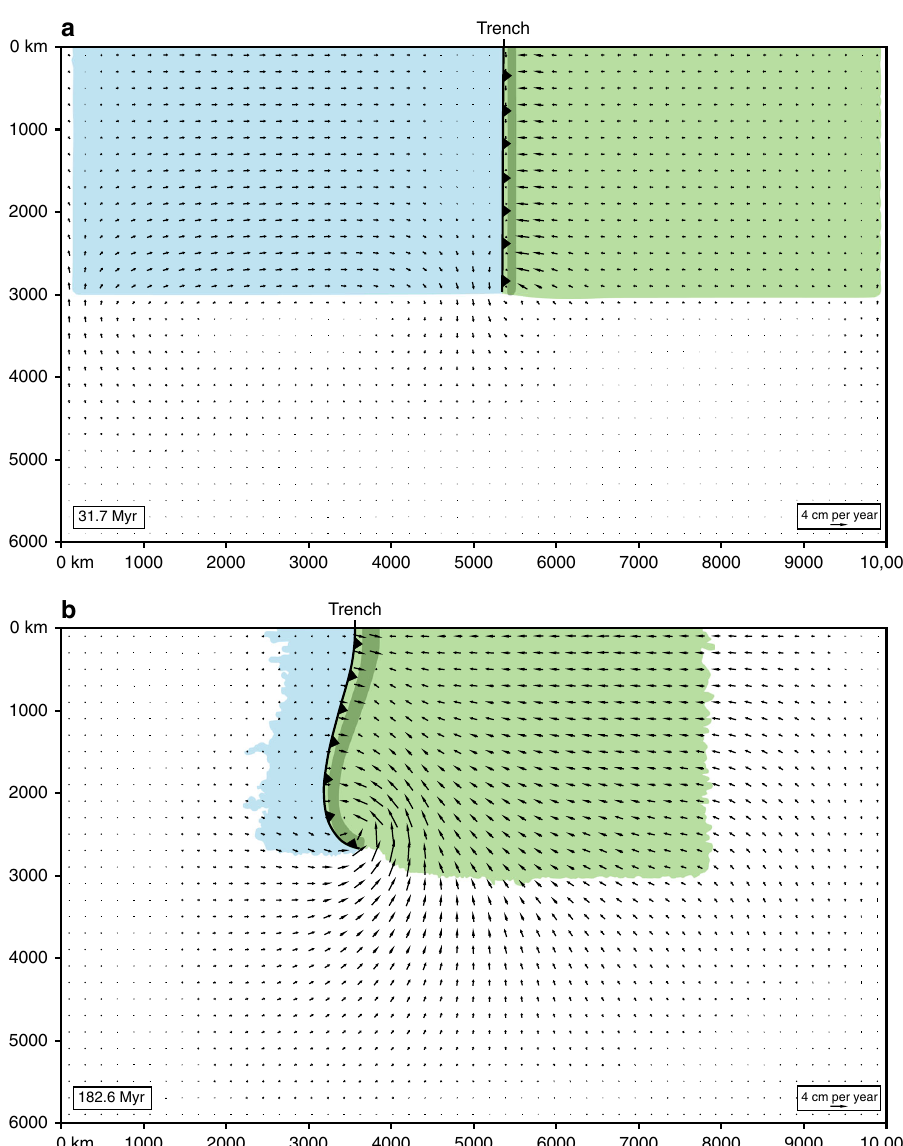
Fig. 4 Model results showing the horizontal velocity fi eld in the mantle at 200 km depth and the outlines of the tectonic plates at the surface. a At 31.7 Myr. b At 182.6 Myr. Also shown are the trench (black continuous line with black triangles) and the outline of the slab at 200 km depth (elongated dark green feature on the right-hand side of the trench running sub-parallel to the trench). Note that the subducting plate is in blue, while the overriding plate is in